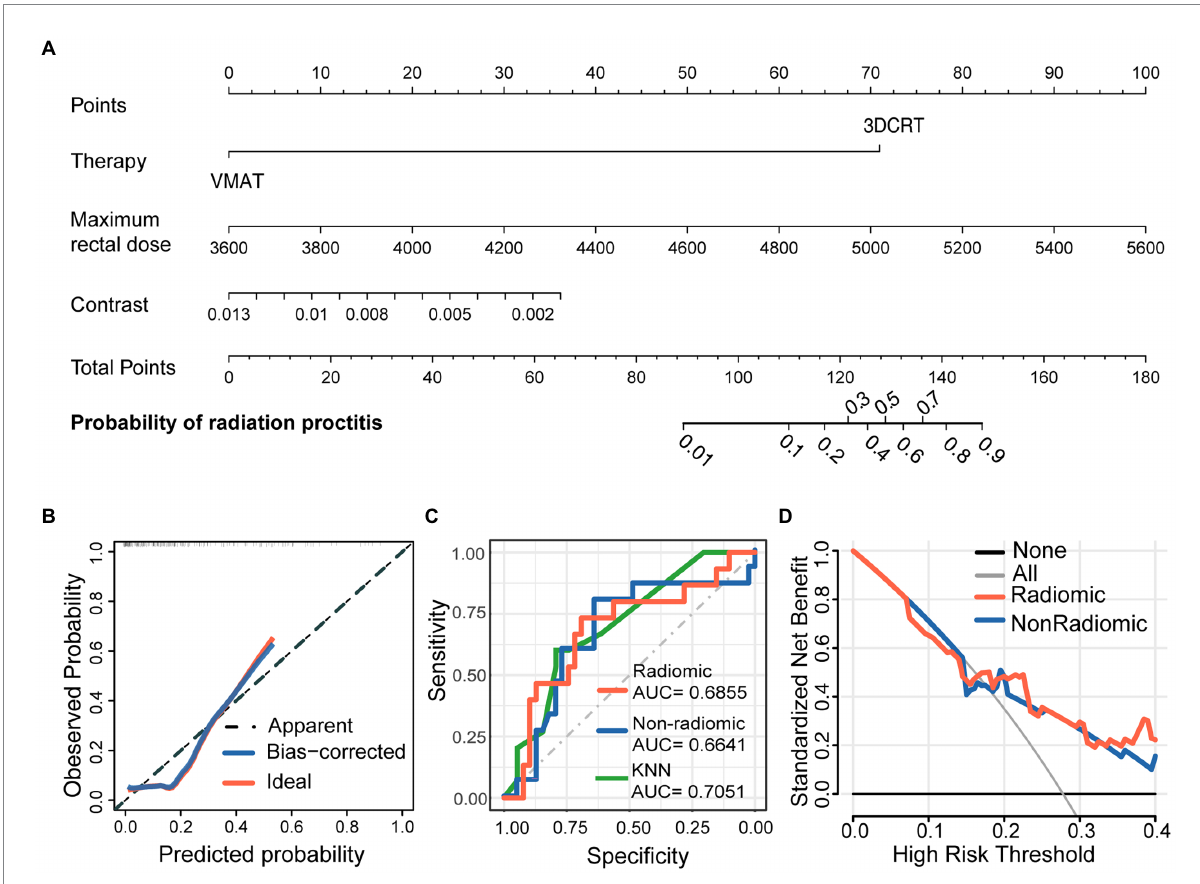
FIGURE 3 Nomogram for severe radiation proctitis prediction in postoperative cervical cancer patients, calibration of the nomogram, and decision curves in the overall patients. The combined nomogram (A) incorporated clinical, dose-volume, and radiomic features. By accumulating the points for each feature, we could quickly calculate the probability of radiation proctitis. All model evaluations were performed on the validation set. The Calibration curves of the combined radiomics nomogram (B) illustrated the relationship between the observed outcome frequencies and the predicted probabilities. The ROC curves (C) demonstrated the accuracy of the radiomic and non-radiomic models and KNN radiomic model. The DCA curves (D) demonstrated the net benefit of the radiomic and non-radiomic